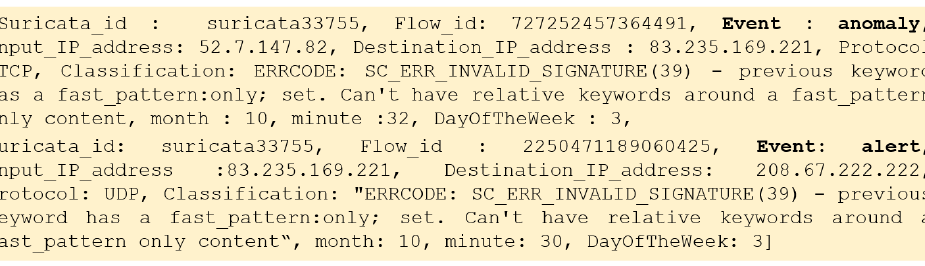
Figure 5. Characteristic logs that correspond to “alert” and “anomaly” <Event> types.